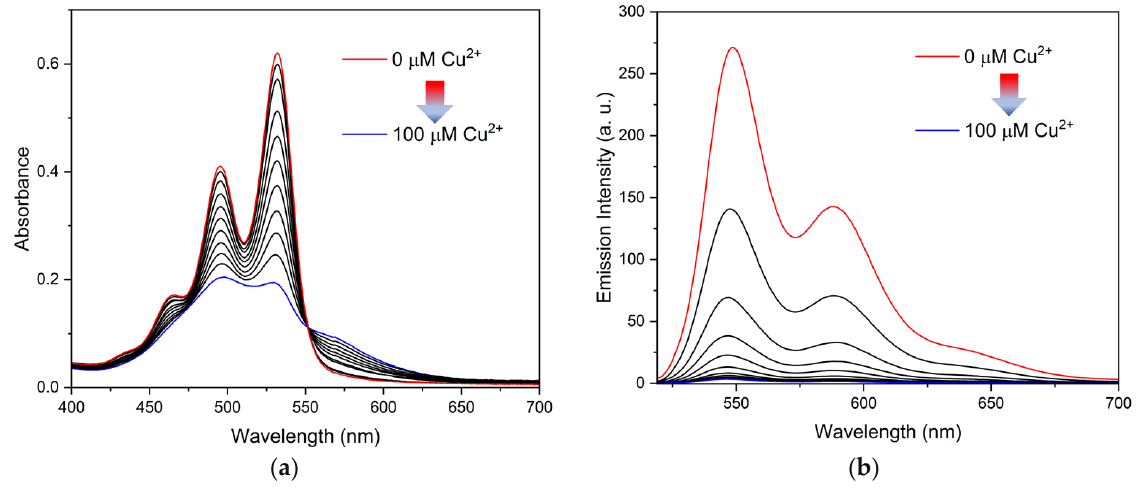
Figure 3. The change in absorption ( a ) and emission spectra ( b ) of APBI-K aqueous solution during formation of coordination induced self-assembly with incremental addition of Cu 2+ ion.